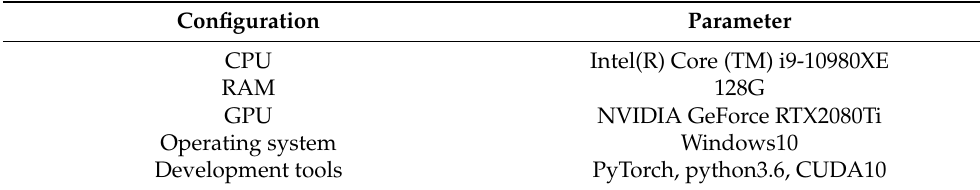
Table 3. Test data parameters.